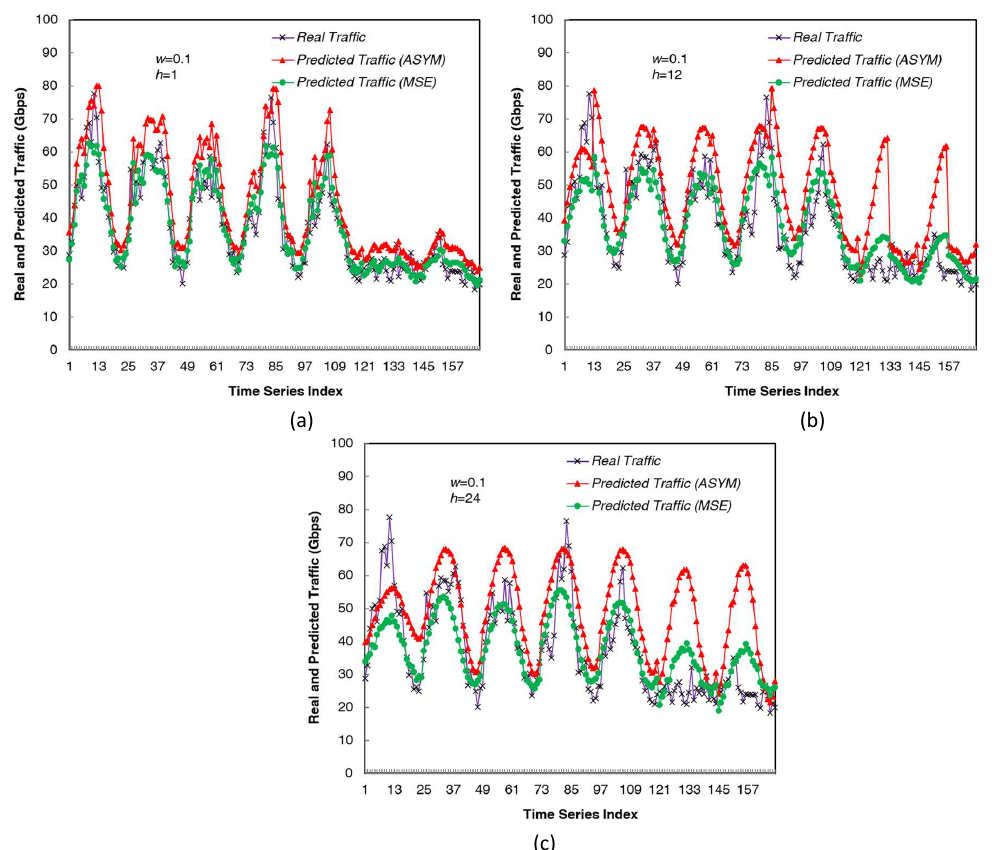
Figure 6. Comparison of the Real, Mean Square Error (MSE) and Asymmetric (ASYM) LSTM prediction values for w = 0.1 and prediction step h equal to 1 ( a ), 12 ( b ) and 24 ( c